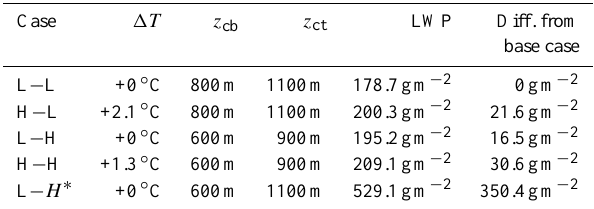
Table A2. Adiabatic estimate of cloud liquid water with several dif- ferent parameters. (cid:49)T refers to the deviation from the L profile at z cb (green line in Fig. A5). The case name refers to the tempera- ture and humidity conditions imposed; i.e., Case H − L corresponds to the high temperature, low humidity case. H ∗ represents a cloud base height corresponding to Case H, with the additional condition of cloud top height that of Case L (i.e., thicker